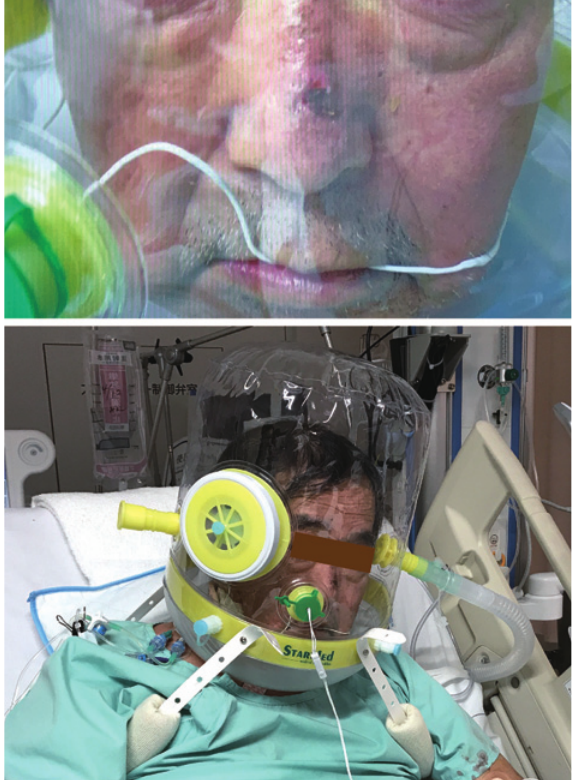
and p u lmonar y